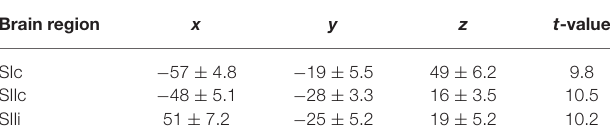
TABLE 1 | Cortical activation in response to tactile stimulation montreal neurological institute (MNI) coordinates of the activation maxima with corresponding t -values and standard deviation for right-sided tactile stimulation . Brain